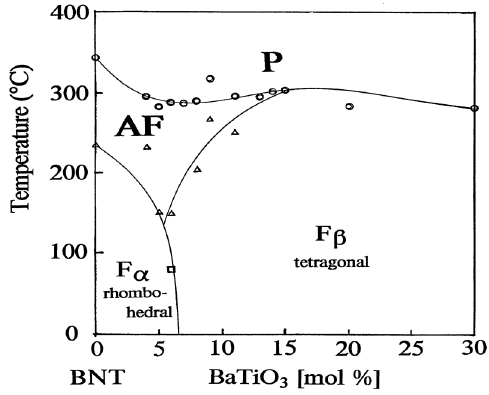
Figure 3. Morphotropic phase boundary in BNT-based solid solutions with BaTiO 3 , for poled ceramics ([72], Copyright from The Japan Society of Applied Physics 1991).